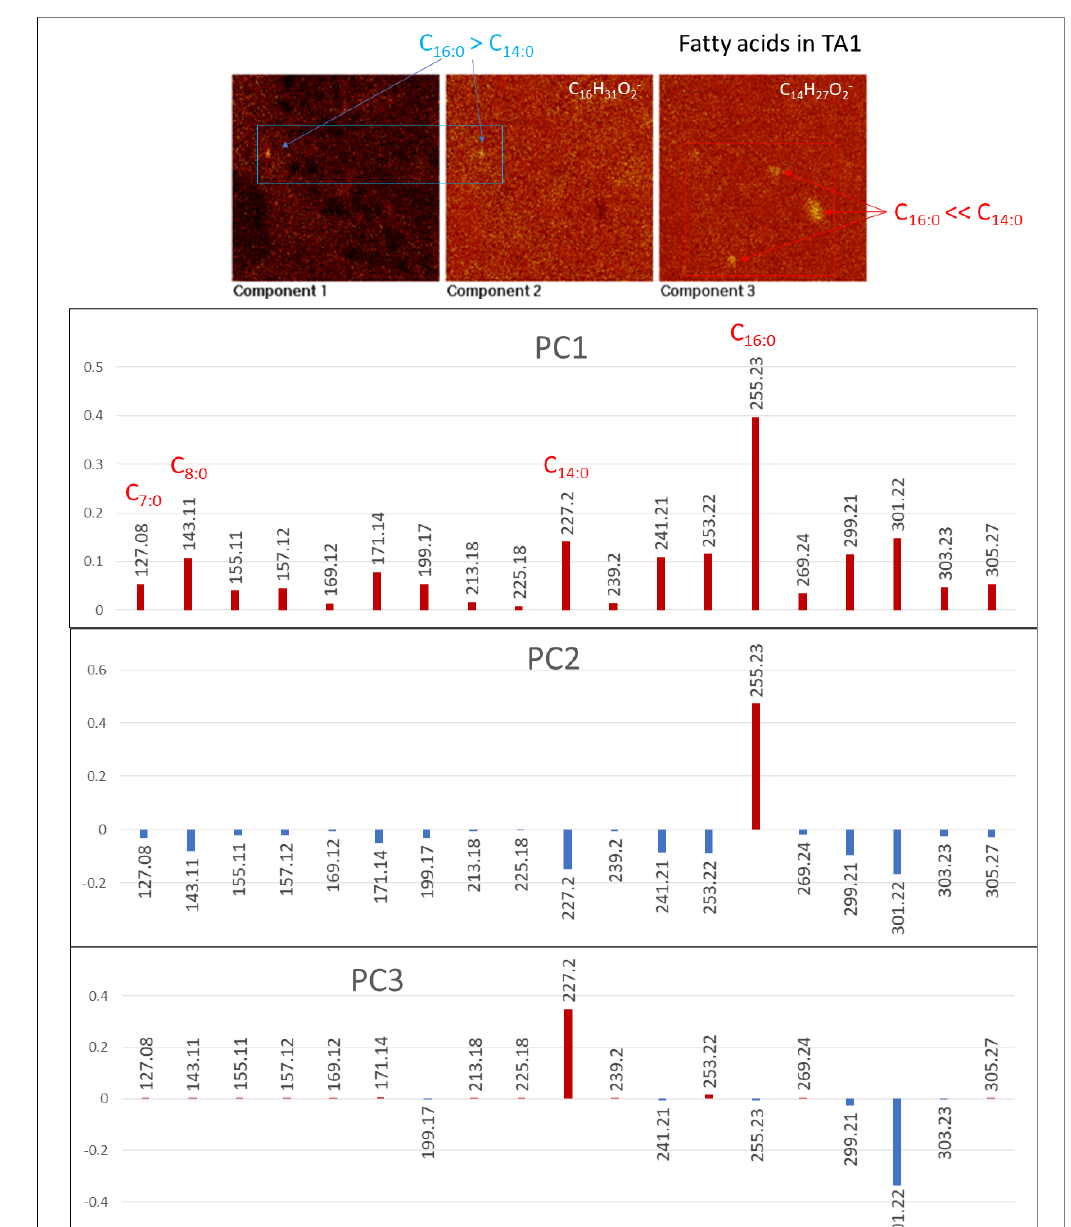
Figure 10. Principal component analysis (PCA) using 19 masses of FA [M − H] − adducts from TA1. It can be observed a variation in the FA composition in different micronodular structures and microclasts. PC1 and PC2 show that C 16:0 followed by C 14:0 is the most abundant FA in TA1, particularly in the micronodular structure pointed by the blue arrows and square. However, C 14:0 is the dominant FA in the sulfate-rich microclasts (red square and arrows) forming the microbrecciated layer (see Figure 2b). The ToF-SIMS images were obtained from a rasterized surface area of a 500 μ m square.